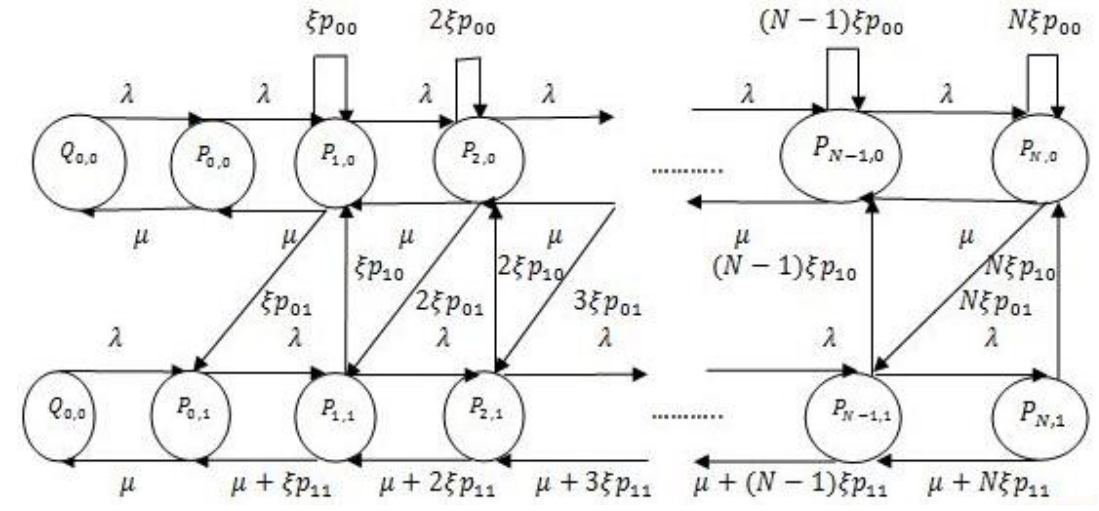
Figure 1: State transition diagram of the queuing